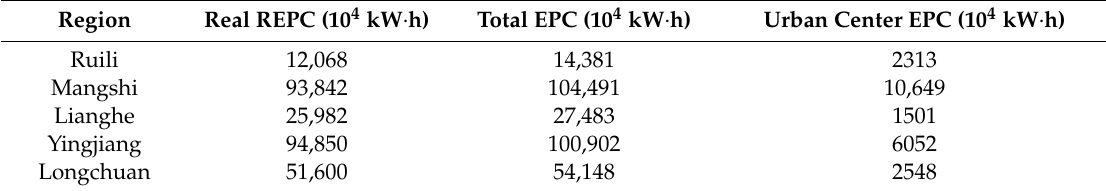
Table 8. EPC estimation results in the DH Prefecture in 2017.